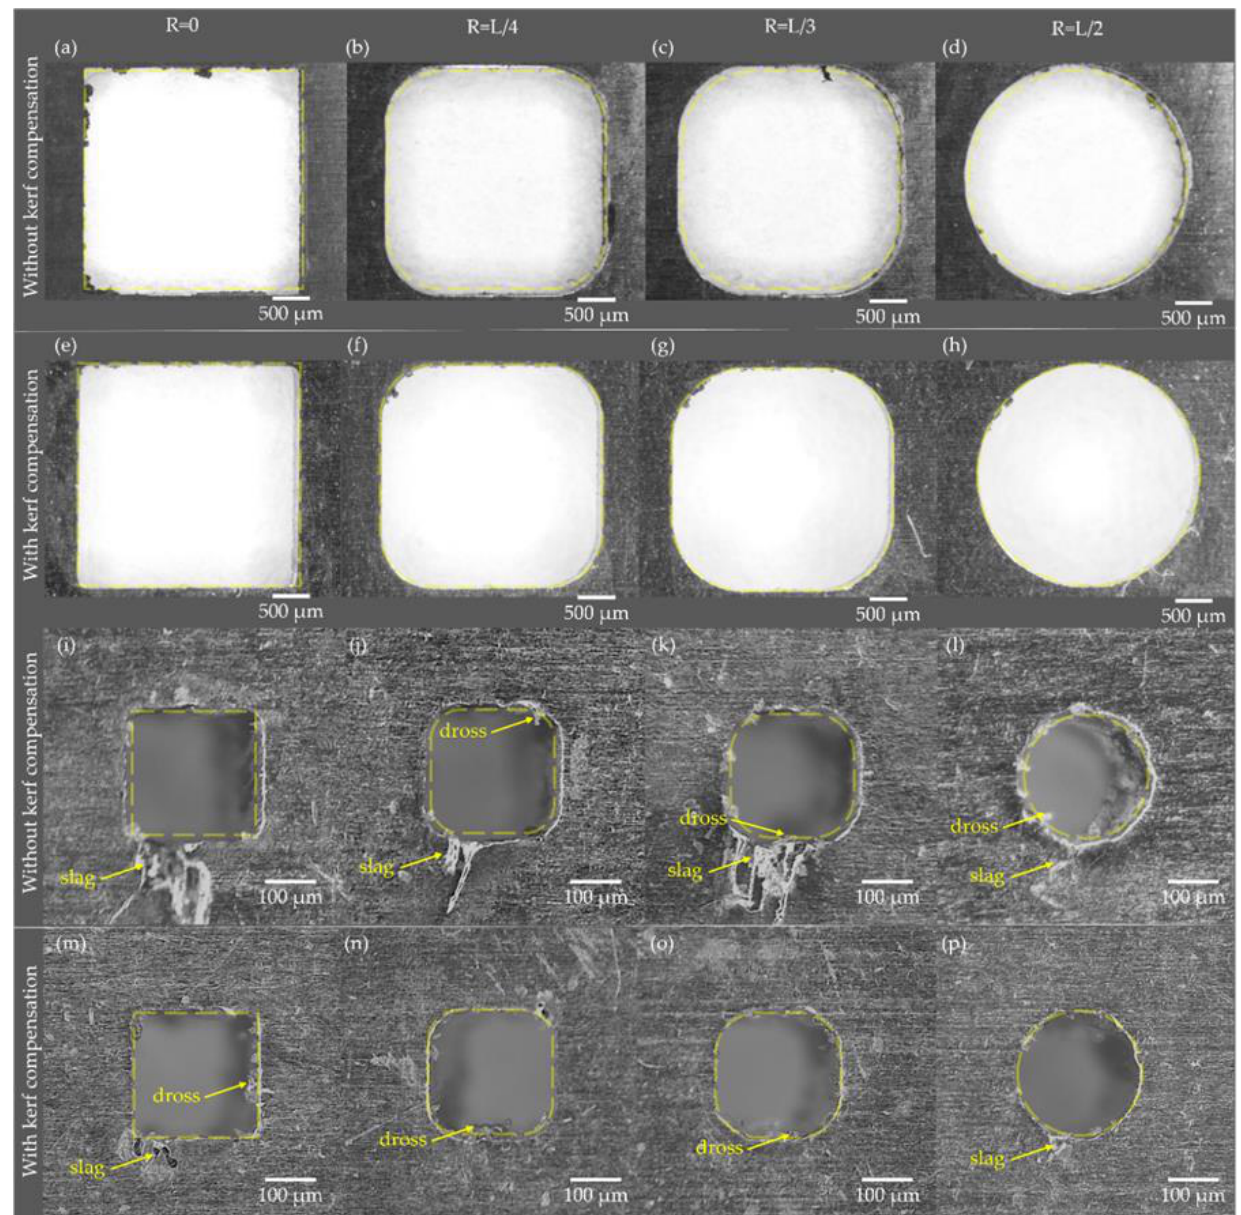
Figure 5. Macro shapes with a length of 3000 µm without compensation ( a – d ) and with compensation ( e – h ) and micro shapes corner radius with a length of 250 µm without compensation ( i – l ) and with compensation ( m – p ).